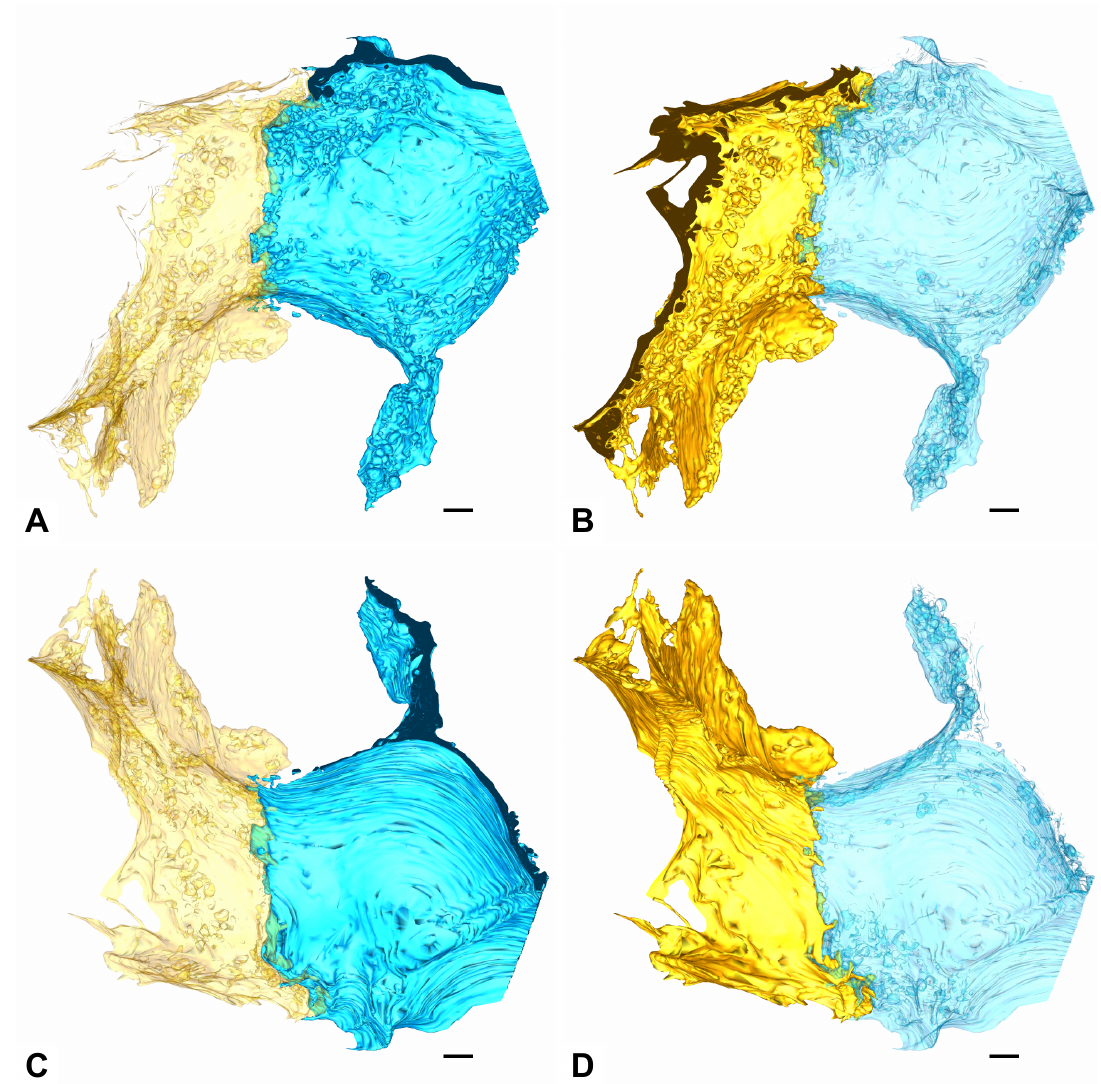
Figure 7. AE1/AE1 contact. ( A , B ) show the yellow and blue AE1 cell domain with their alveolar surfaces. On each image one of both cell domains is shown transparently (A: yellow, B: blue) to visualize overlap. Images ( C , D ) follow the same principle but show the basolateral surfaces. Scale bars: 1 µ